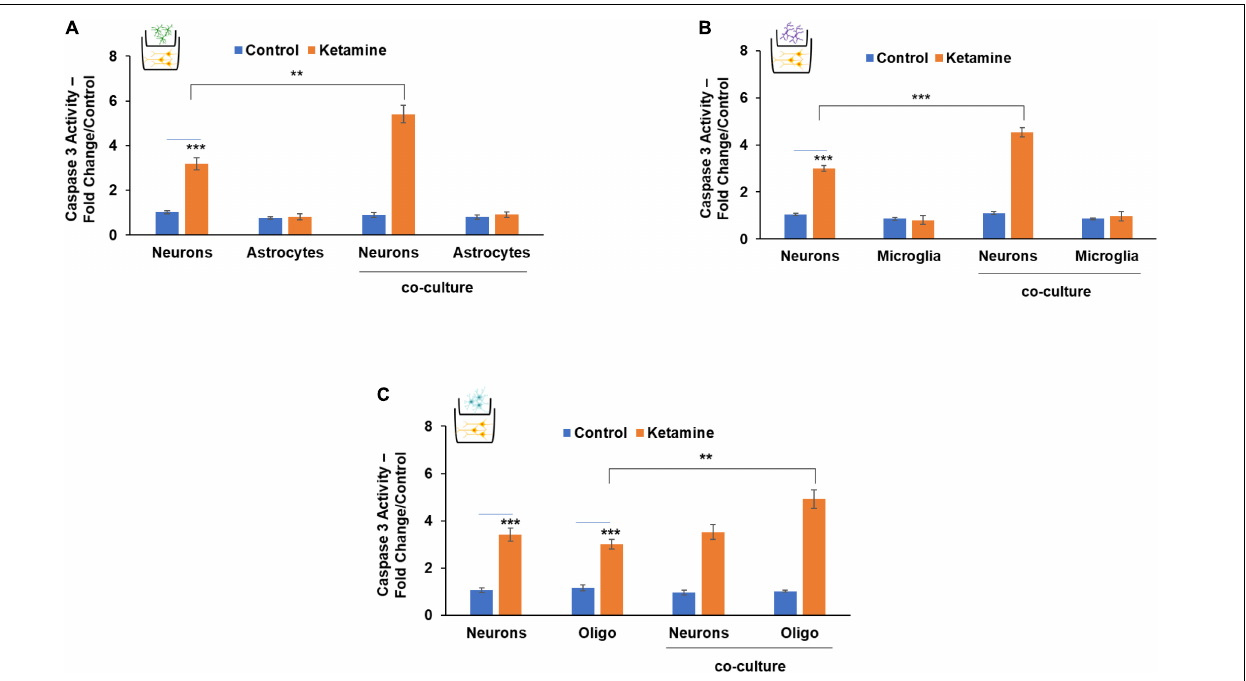
FIGURE 5 | The role of neuron-glia interactions in the neurotoxic effects of ketamine. Neurons and astrocytes (A), neurons and microglia (B) or neurons and oligodendrocytes (C) were plated alone or co-cultured in transwell plates with a 1- µ m filter. The co-cultures were treated with ketamine and caspase 3 activity was determined for the cultured cells after 48 h. The results are the means ± SD of six independent experiments analyzed in triplicates. *** P < 0.001 (co-cultured neurons vs. neurons alone (A,B) or co-cultured oligodendrocytes vs. oligodendrocytes alone (C). ** P < 0.01 and *** P < 0.001 (ketamine-treated cells vs.